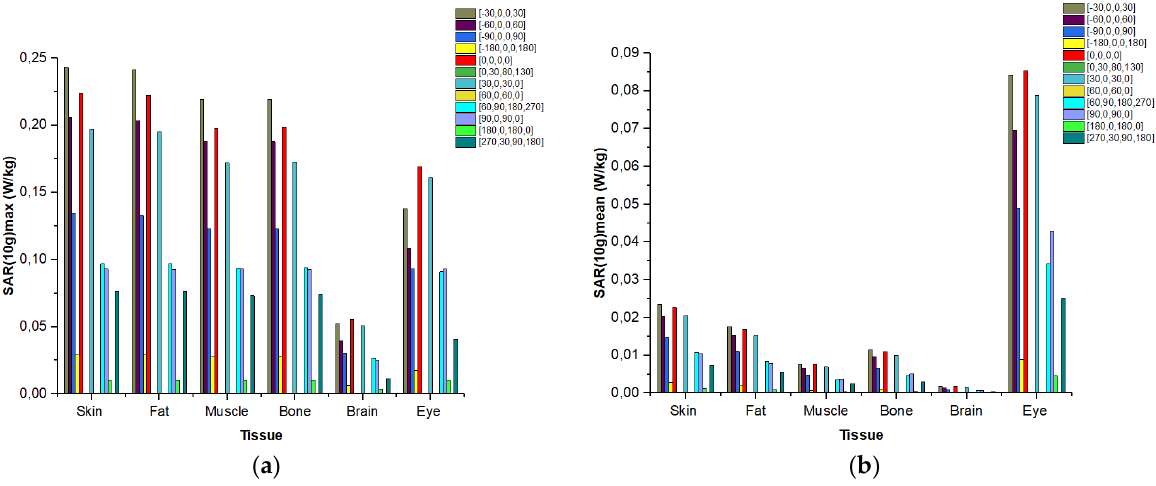
Figure 5. ( a ) SAR max (W/kg) and ( b ) SAR mean (W/kg) inside tissues models according to phase shift between the elements of 1 × 4 array antenna (various beam steering directions).